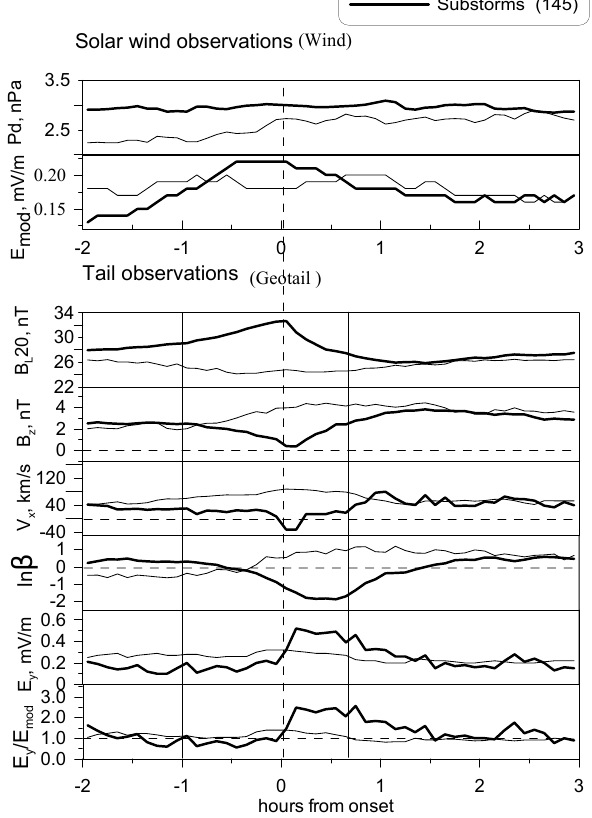
Fig. 2 . Variations of the average values of the solar wind (top panel) and plasma sheet (bottom Fig. 2. Variations of the average values of the solar wind (top panel) panel) parameters for SMC and substorm events. E mod was calculated according to model and plasma sheet (bottom panel) parameters for SMC and substorm number 1 (see Table). V x and E y were additionally time-averaged (with 1h wide sliding window). events. E mod was calculated according to model number 1 (see Table). V x and E y were additionally time-averaged (with 1-h wide sliding